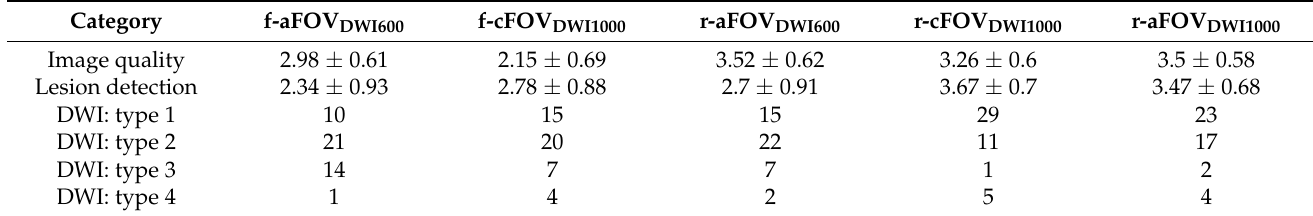
Table 3. Ratings for the assessed qualitative image parameters.